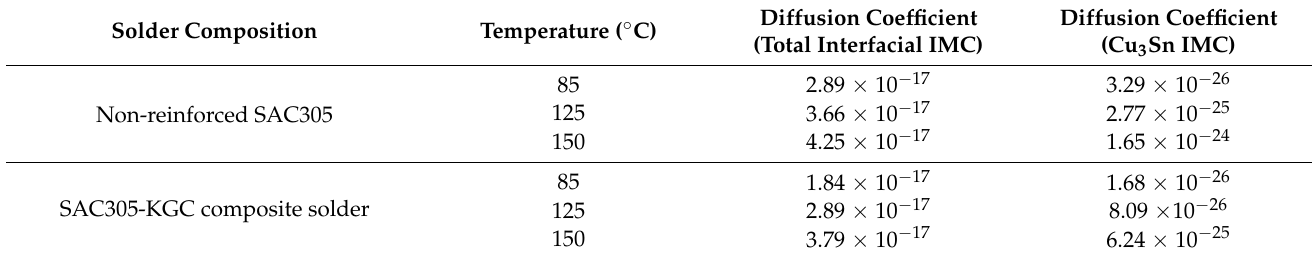
Figure 14. The relationship between the total interfacial IMC thickness curves and ageing temperature and ageing time for ( a ) total interfacial IMC for non-reinforced SAC305, ( b ) total interfacial IMC for SAC305-KGC composite solder ( c ) Cu 3 Sn IMC for non-reinforced SAC305 and ( d ) Cu 3 Sn IMC for SAC305-KGC composite solder. Table 1. Diffusion coefficient for total interfacial IMC layer and Cu 3 Sn